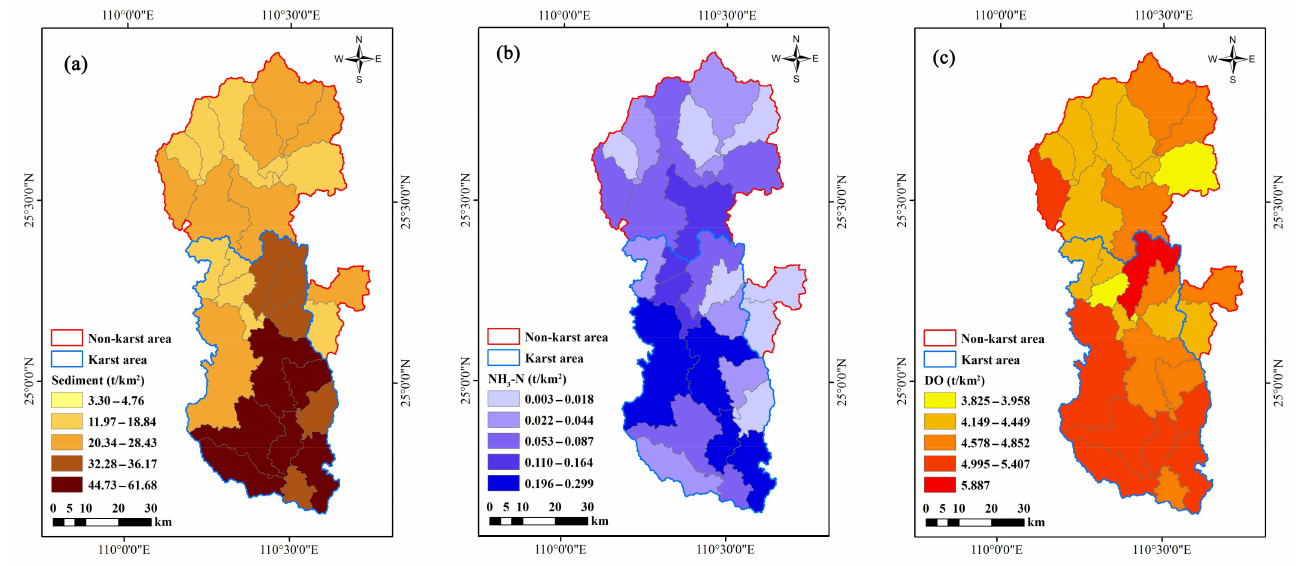
Figure 7. Spatial distribution of unit pollution load in each sub-basin (t/km 2 ): ( a ) sediment; ( b ) NH3-N; and ( c ) DO.